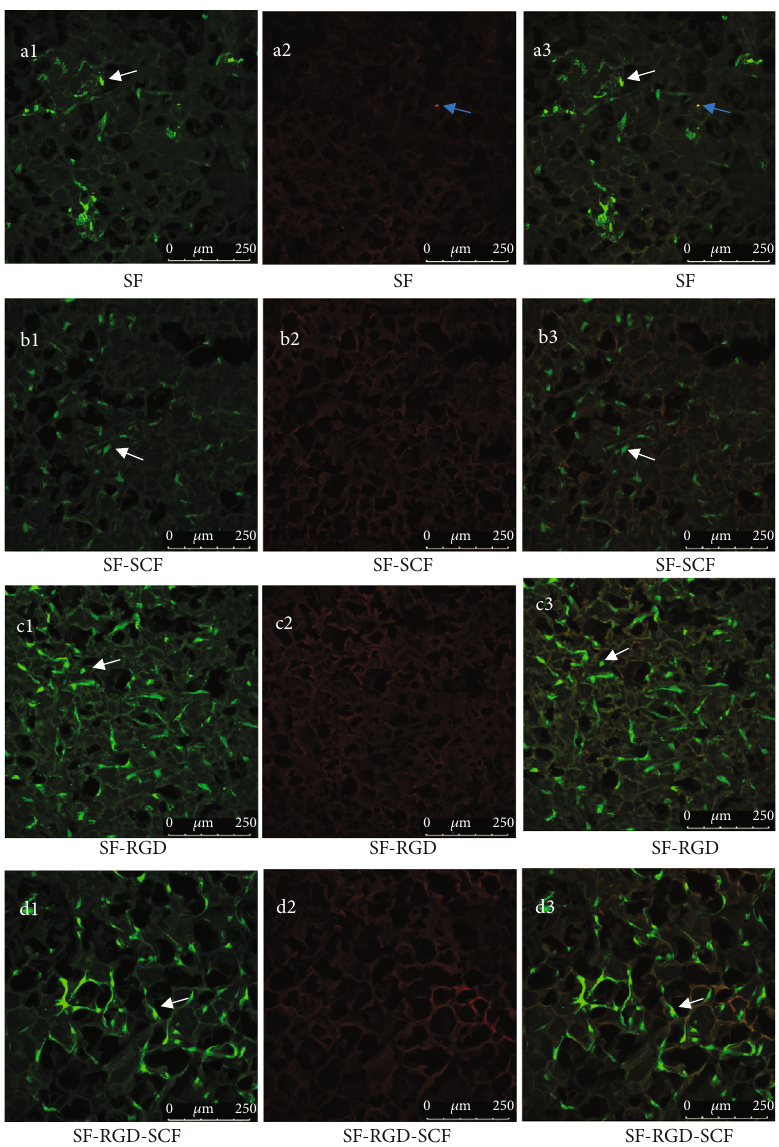
Figure 8: Laser scanning confocal microscopy images showing live and dead cells after 7 d seeding. Live cells show as fl uorescent green (a1, b1, c1, d1). Dead cells show as red (a2, b2, c2, d2). Merged pictures of live and dead cells (a3, b3, c3, d3) (white arrows: live cells; blue arrows: dead